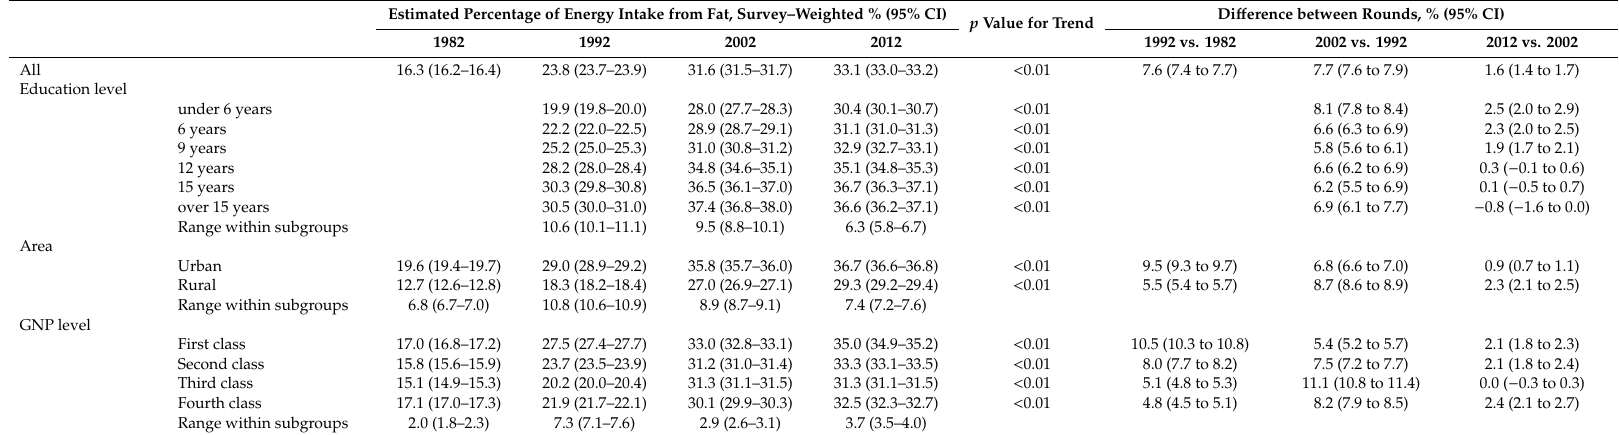
Table 3. Trends and Disparities in the Estimated Percentage of Energy Intake from Fat of Adults Aged 18 Years or Older by CNNS Round, 1982–2012 1